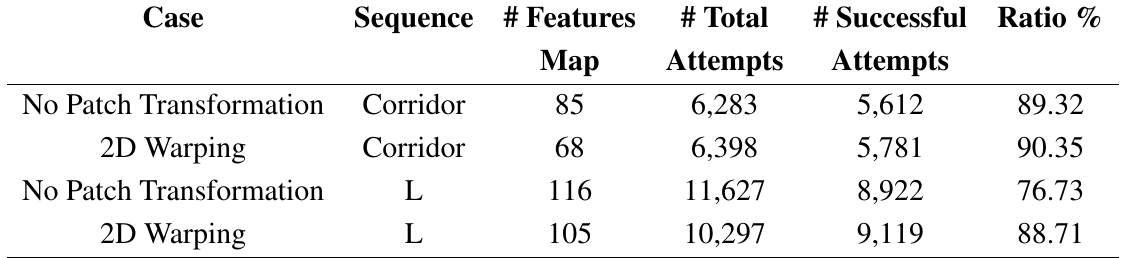
Table 3. Comparison of patch matching techniques: no patch transformation and 2 D warping.